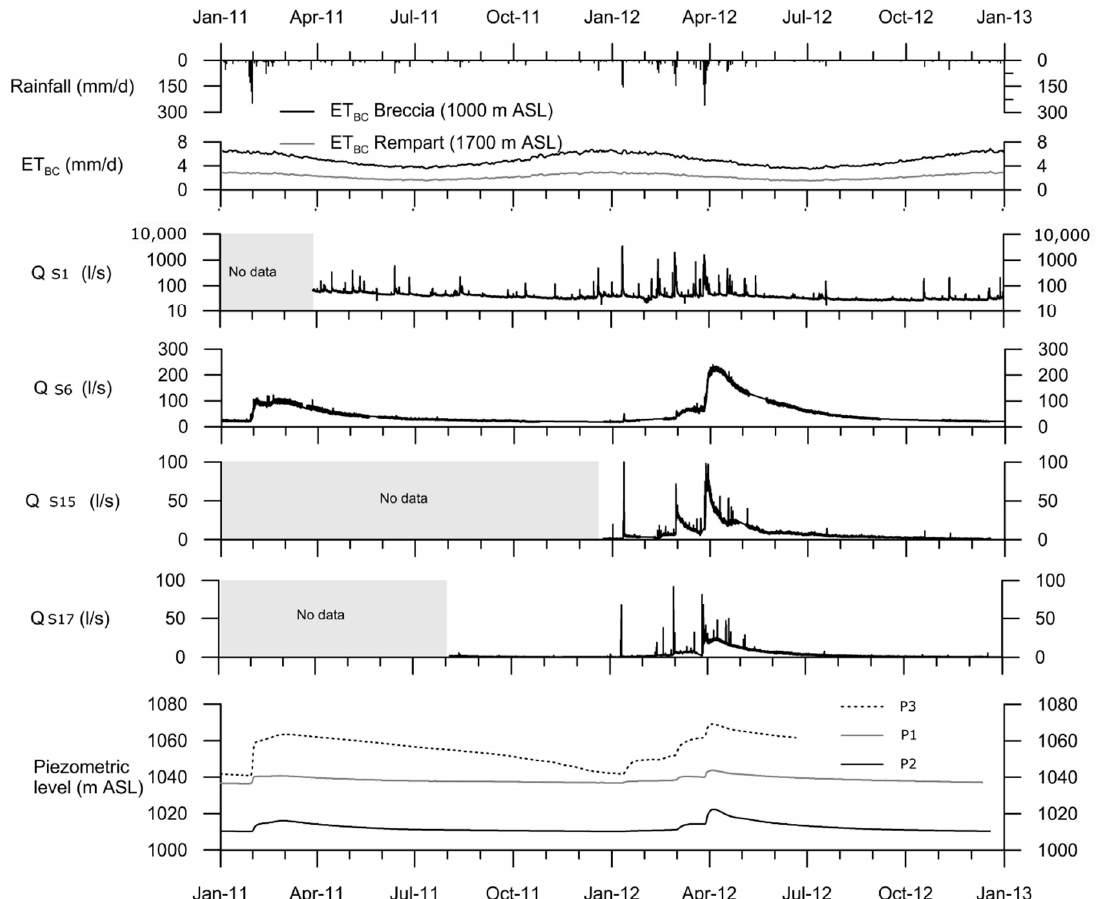
Figure 6. Presentation of the piezometric and hydrological chronicles recorded in the Grand Ilet area, with Q S1 the hydrological station at the foot of the rampart and Q S6, Q S15 and Q S17 the breccia springs. The daily mean interannual PET BC data are shown for the ramparts and the breccias. The other springs (S2–S5, S7–S11, S13–S16) (Figure 2) were not continuously monitored, because